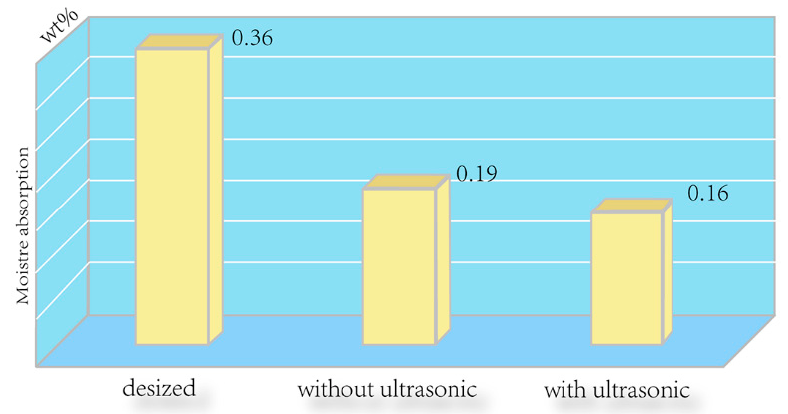
Figure 6. Water absorption of the composites reinforced by the desized CF, CNTs deposited CF without ultrasonication, CNTs deposited CF with ultrasonication.